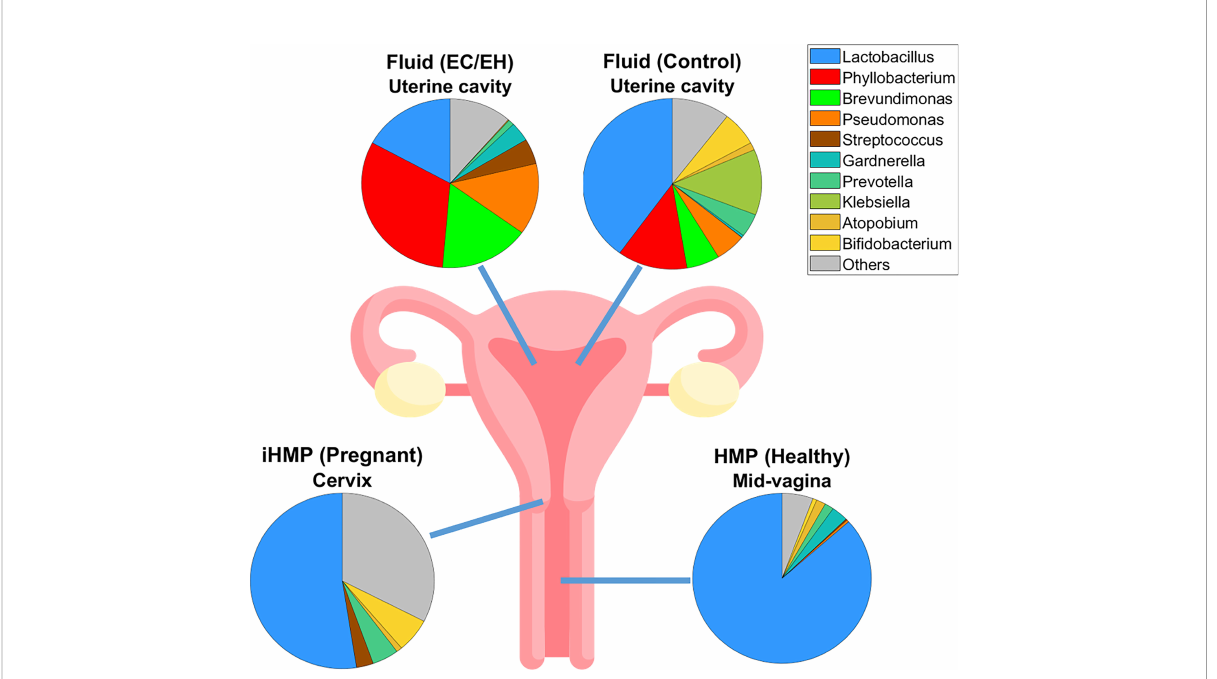
FIGURE 7 Pie plots showing the microbial compositions at the genus level in various levels of the female reproductive tract. A stepwise decrease in the relative abundance of the genus Lactobacillus was observed, as follows: 1) mid-vaginal microbiota of healthy non-pregnant women, 2) cervical microbiota of pregnant women, 3) endometrial lavage microbiota of women with benign endometrial lesions, and 4) endometrial lavage microbiota of women with EC/EH. Data on the mid-vaginal microbiota of healthy non-pregnant women and the cervical microbiota